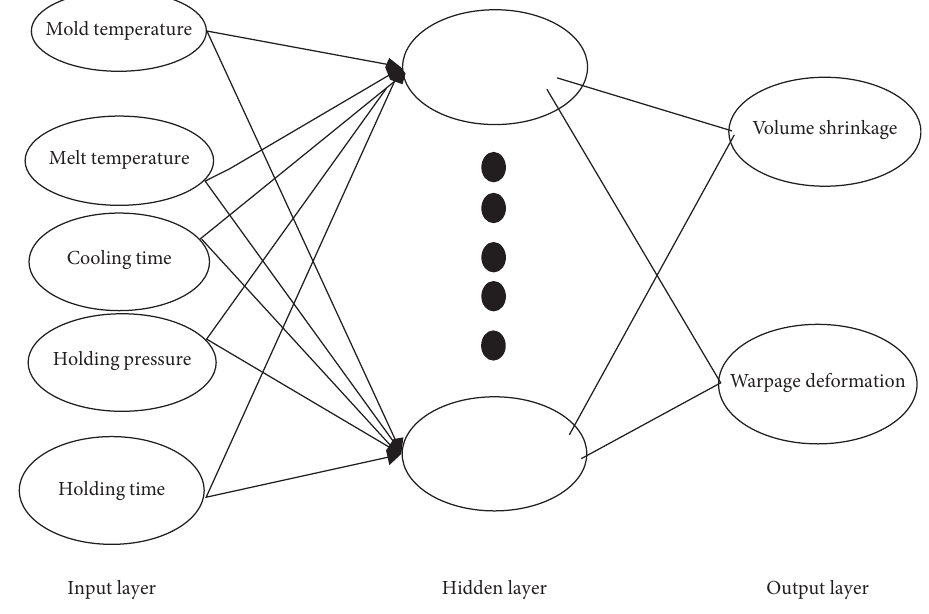
Figure 19: BP network structure.